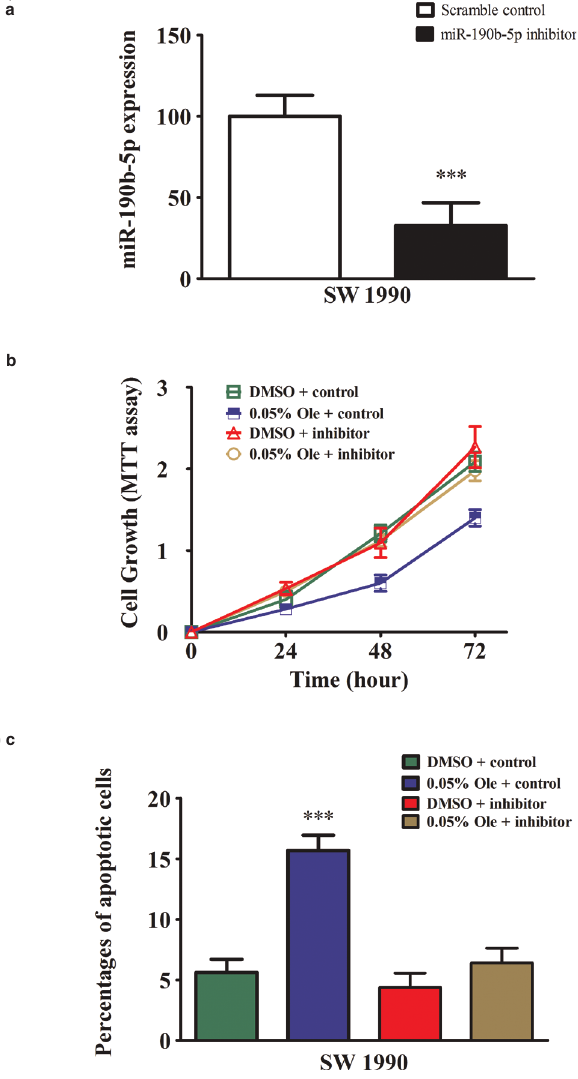
Fig. 4. MiR-190b-5p is required for Ole-mediated pan- creatic cancer inhibition. (a) Real-time PCR analysis of miR-190b-5p expression in cells transfected with miRNA inhibitor or scramble control. (b) Cell growth analysis of pancreatic cancer cells treated with DMSO of 0.05% Ole. Forty-eight hours before the treatment, cells were transfected with miR-190b-5p inhibitor or control. Cell proliferation was monitored by MTT assay every 24 h for 3 days. (c) Cell apop- tosis analysis of pancreatic cancer cells treated with DMSO of 0.05% Ole. Seventy-two hours before the treatment, cells were transfected with miR-190b-5p inhibitor or control. Apoptotic cells were stained positively with Annexin V/PI. The data were presented as means ± SD of three independent experiments (* P < 0.05, ** P < 0.01, and *** P < 0.001 as compared with